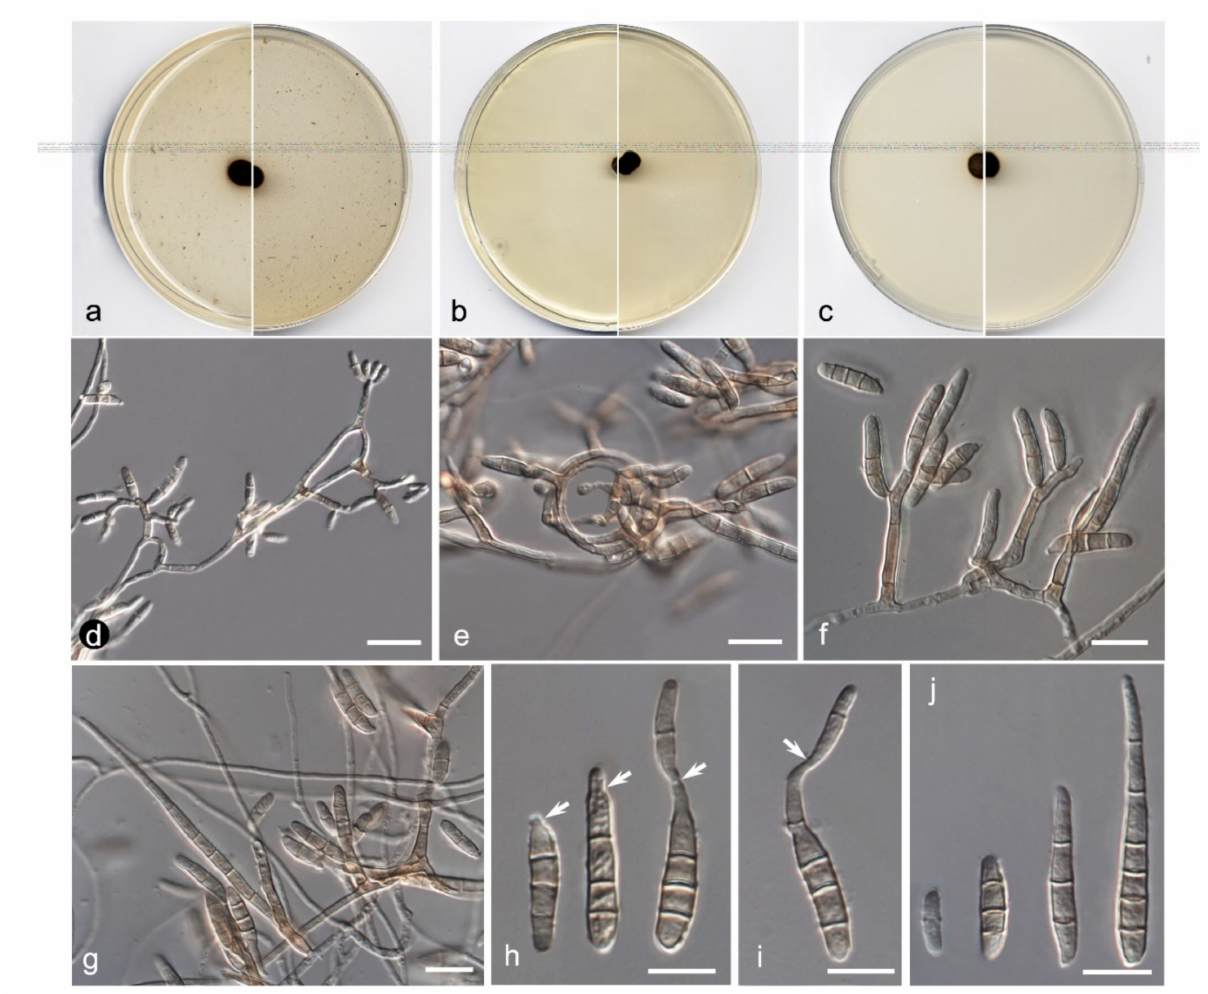
Figure 13. Pseudosigmoidea robusta . FMR ( a ) Colonies on OA ( b ) MEA ( c ) and PDA after two weeks at 25 ± 1 ◦ C (surface, left; reverse, right); ( d – g ) Conidiophores; ( h , i ) Conidia displaying a secondary conidiogenesis (white arrows); ( j ) Conidia showing variation in size. Scale bars: ( d – j ) = 10 µ